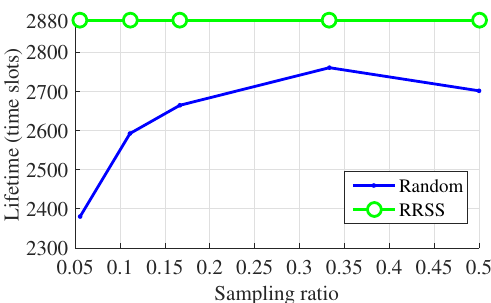
Figure 9. Lifetime over sampling ratio for WSNs from Intel Berkeley Research Lab.